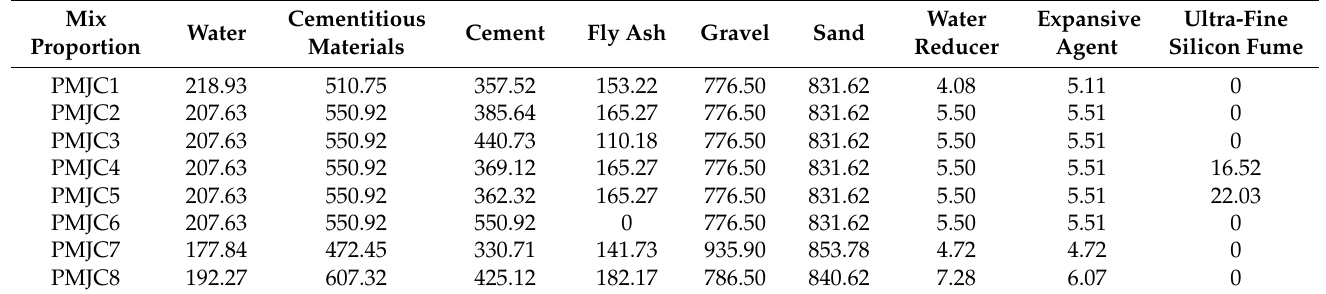
Table 4. The weight of raw materials per cubic meter of PMJC (unit: kg/m 3 ).